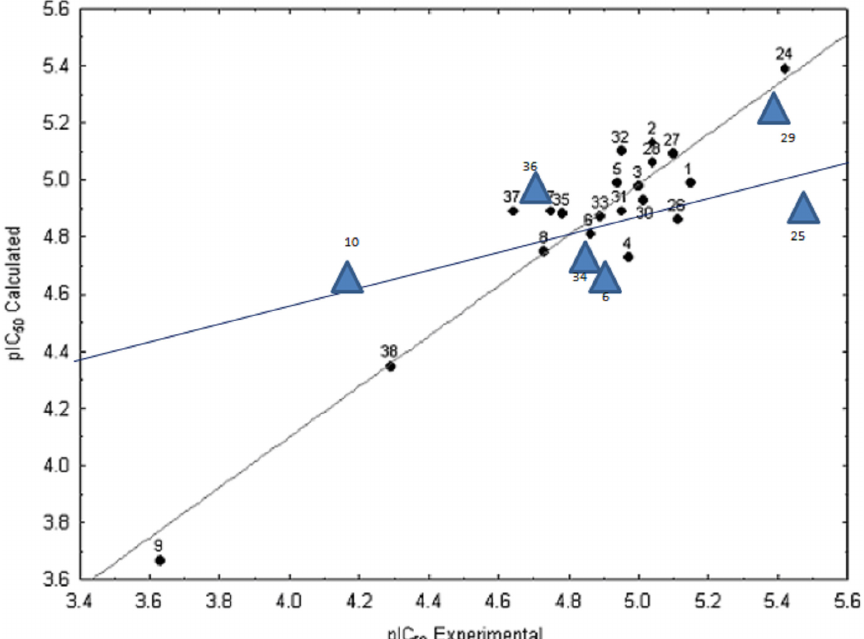
) for the training (black balls) and test 50